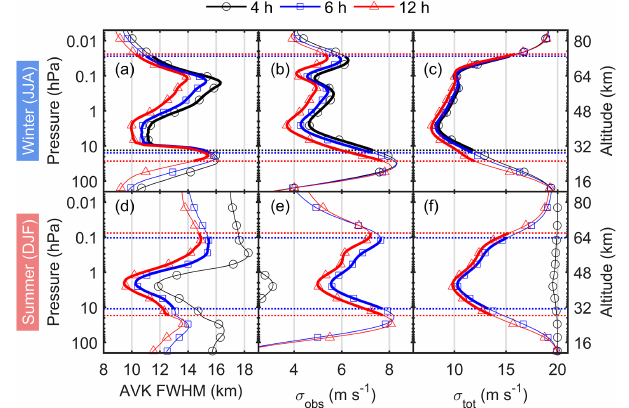
Figure 13. As Fig. 7, but for retrievals using the O 3 231.28GHz, O 3 250GHz, CO 230.54GHz, and combined CO 230.54GHz and O 3 231.28GHz atmospheric lines and a 60 ◦ zenith viewing